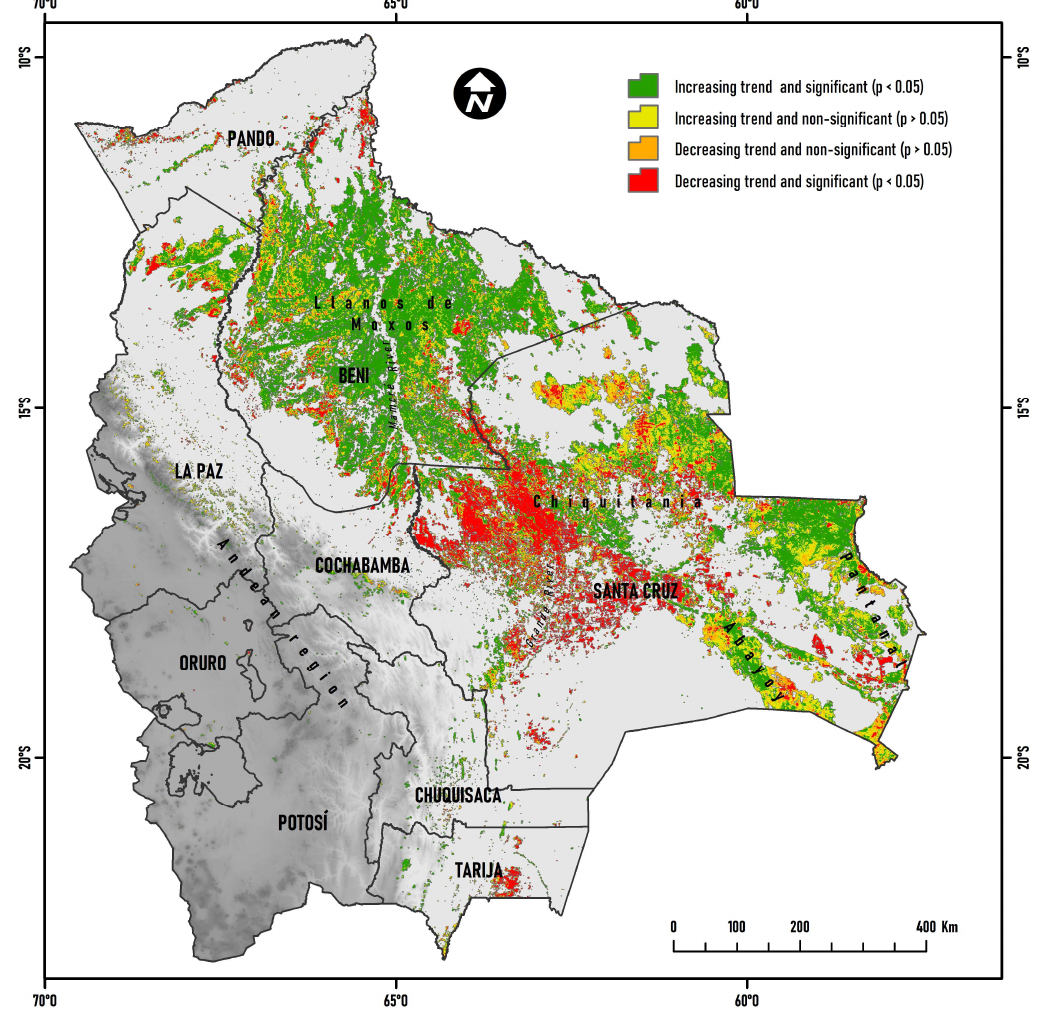
Figure 3. Spatial trend of post-fire natural cover increases or decreases in Bolivia (2001–2021) based on the Mann-Kendall test and statistically significance values ( p < 0.05, p > 0.05).